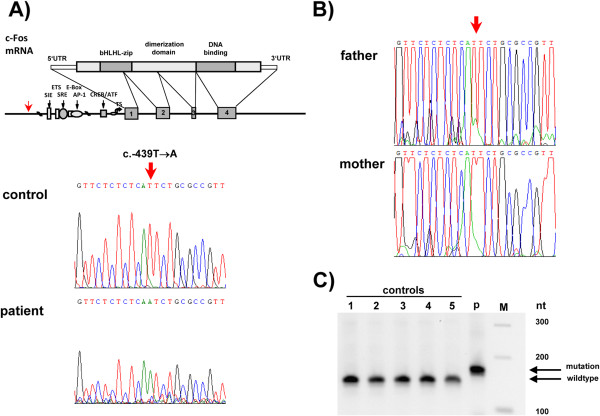
Identification and impact of a homozygous c-fos promoter point mutation in the patient. A) A homozygous point mutation in c-fos promoter (T → A) at position c.-439 was identified in the patient. B) The mutation was not identified in the patient’s father or mother or C) in a restriction based assay with 319 control subjects. Representative samples are shown (lane 1–5; p: patient; M: size standard).